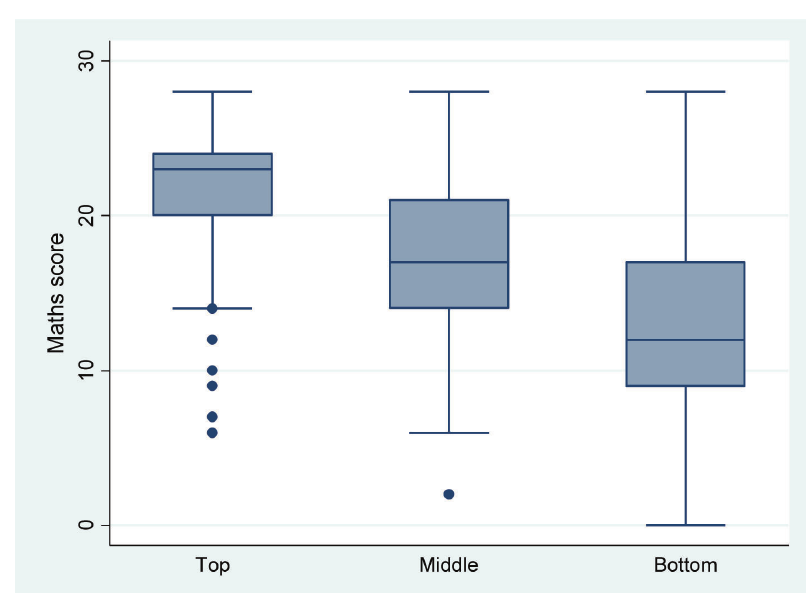
Figure 1: Distribution of Progress in Maths scores: sample pupils across streams n = 840; Mean for all pupils = 18.2. Line represents median, box represents 25th and 75th percentiles (Q1 and Q3, respectively), whiskers represent Q3+1.5(Q3–Q1) / Q1–1.5*(Q3–Q1).